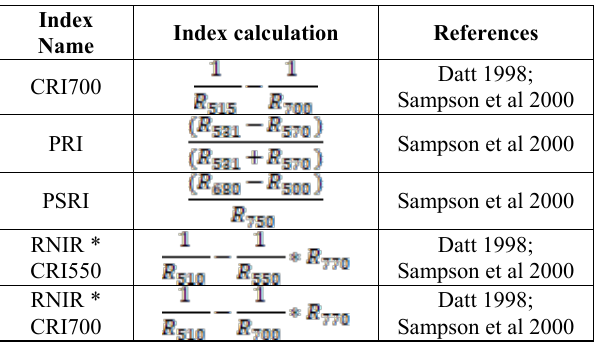
Table 3.Remote sensing Indices for Carotenoid measurement